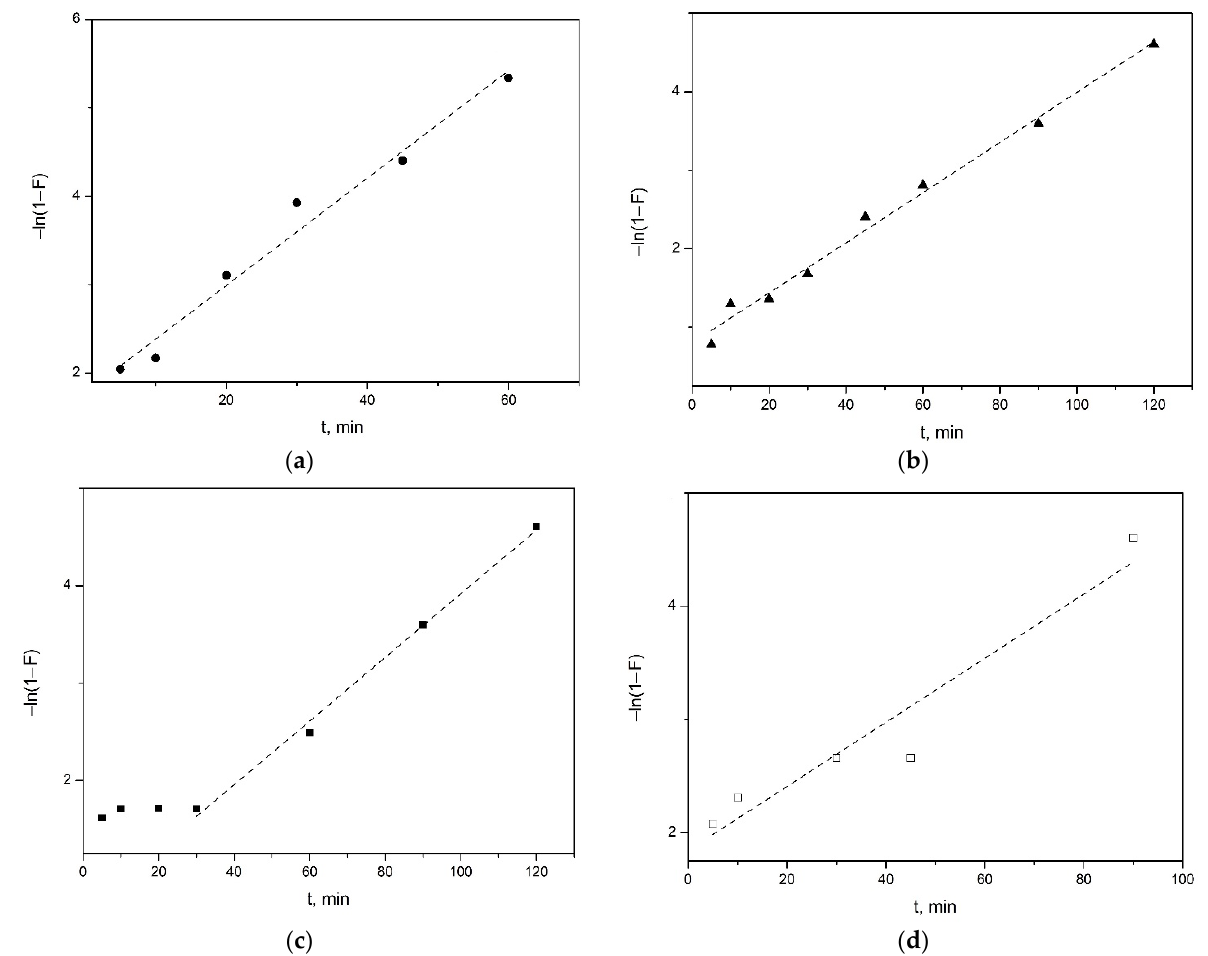
Figure 8. Dependence “ − ln(1 ‐ F) ‐ t” in systems: “MB—porous aluminosilicate” for the samples with different morphology: ( a ) — spheres, ( b ) — nanosponges, ( c ) — nanotubes, ( d ) — plates.